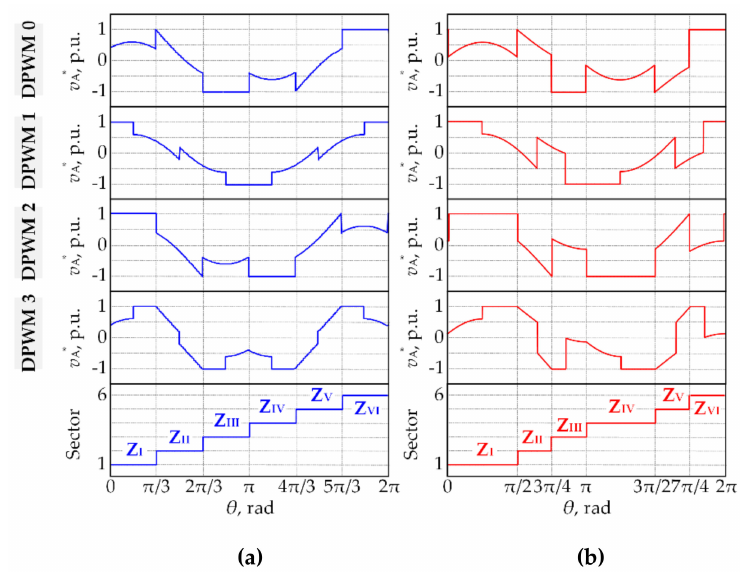
Figure 5. Modulation signals of DPWM0–DPWM3 and IDPWM0–IDPWM3: ( a ) DPWM0–DPWM3 ( b